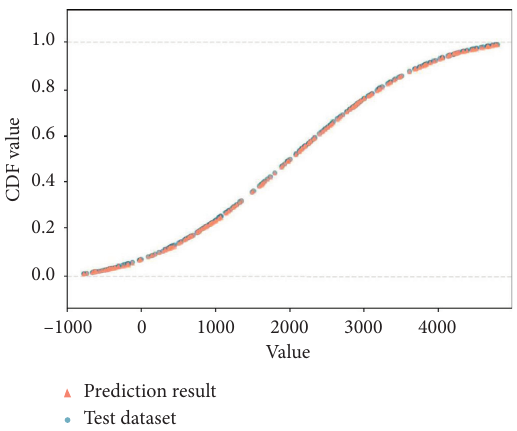
Figure 6: Illustration of a CDF example obtained by LNN. The x - axis represents values of unsorted elements in the test dataset, and the y -axis represents CDF values. In the plot, the pink triangle- shaped points depict the CDF values predicted by LNN, the blue points present the true CDF values of unsorted elements in the test dataset, and the lower and upper gray lines are the lower and upper bounds of the CDF (i.e., 0 and 1), respectively. The test dataset in this figure is the same as that in Figure